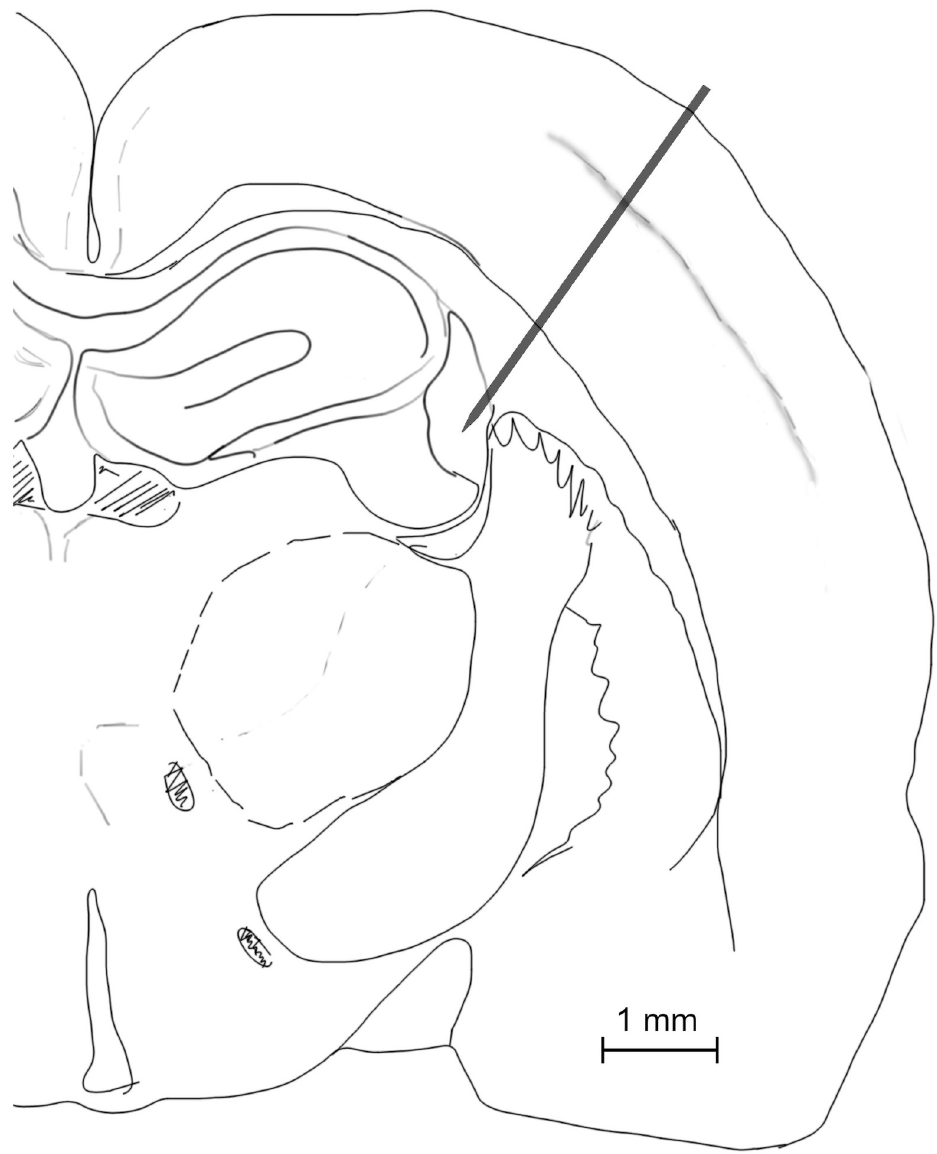
Fig 6. Location of Neuropixels bank 0 in a barrel cortex. Schematic outline of a brain slice drawn under fluorescent stereomicroscope (Olympus SZX10) visualizing the red trace of a probe covered before implantation with DiI lipophylic dye (1,I’ dioctadecyl 3.3,3’,3’ tetramethyl-indocarbocyanine perchlorate; Sigma-Aldrich).